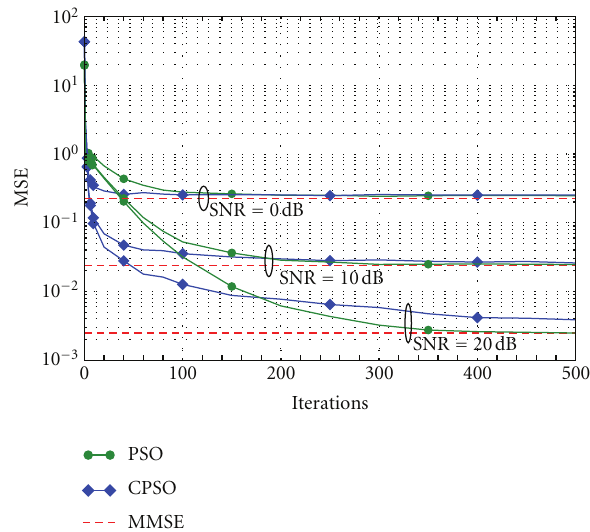
Figure 3: Convergence speed comparison of PSO and CPSO for dif- ferent SNR values compared to the optimum MMSE performance with a 4 × 4 MIMO system.